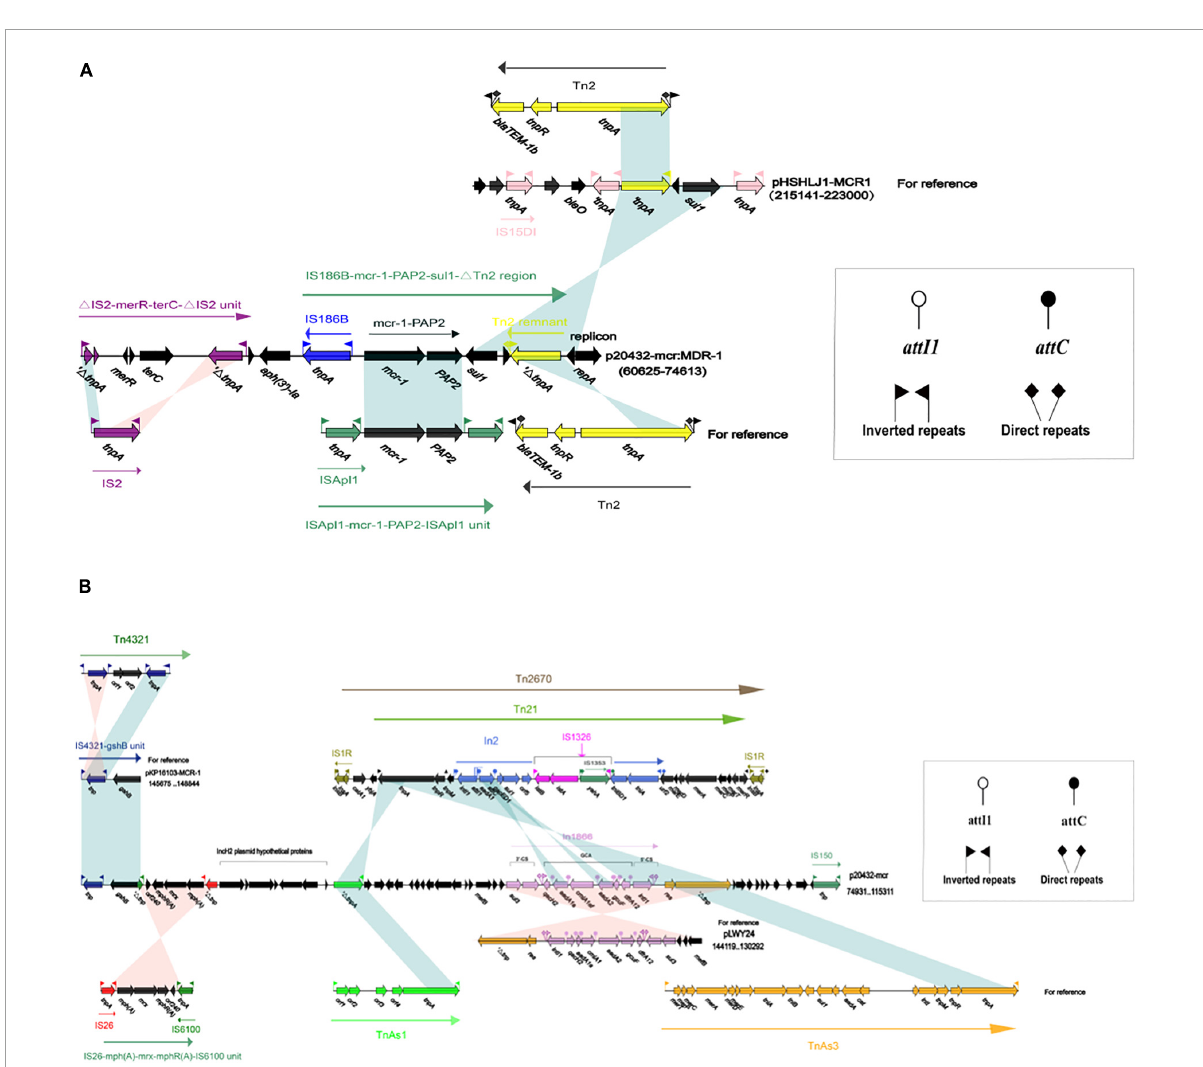
FIGURE10 The organization and alignment of MDR-1 region of p20432- mcr . (A) Different colors indicate different moving elements, and arrows indicate genes. Shading indicates that the homology of the two parts of nucleic acids is greater than 95%, and the number in parentheses indicates the location of the fragment in the plasmid. (B) The organization and alignment of MDR-2 region and In 1866 -related region of p20432- mcr . Different colors indicate different moving elements, and arrows indicate genes. Shading indicates that the homology of the two parts of nucleic acids is greater than 95%, and the number in parentheses indicates the organization and alignment of MDR-2 region and In 1866 -related region of p20432- mcr .